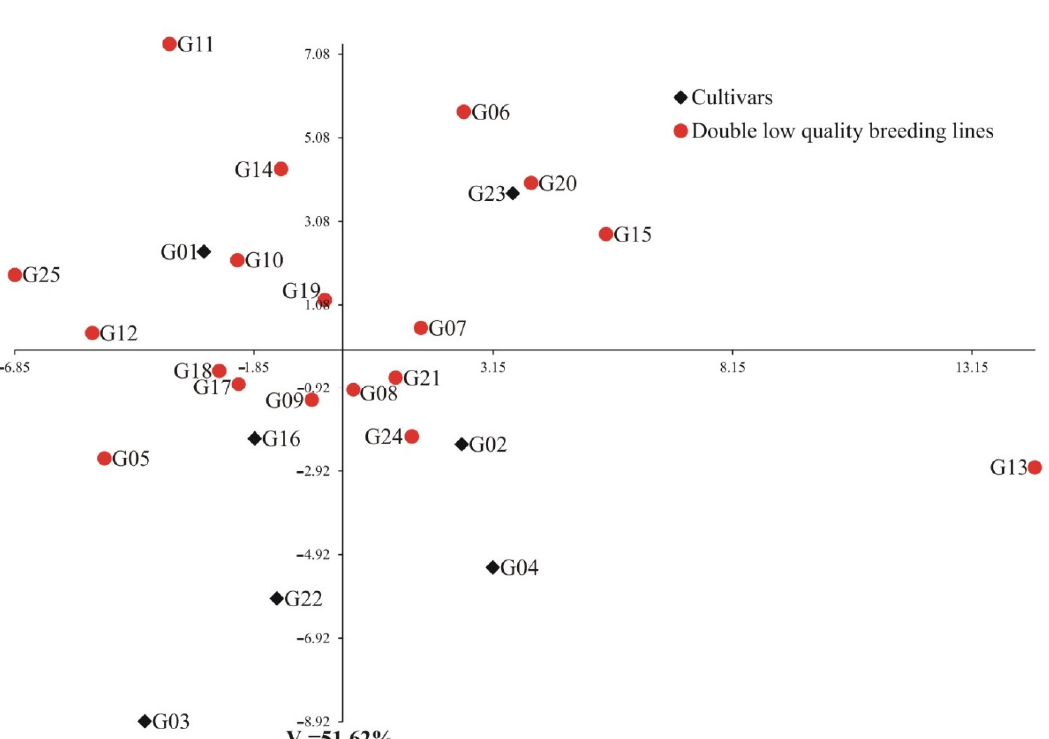
Figure 4. Distribution of 25 genotypes of winter oilseed rape ( Brassica napus L.) in the space of the first two canonical variates in Borowo 2016.